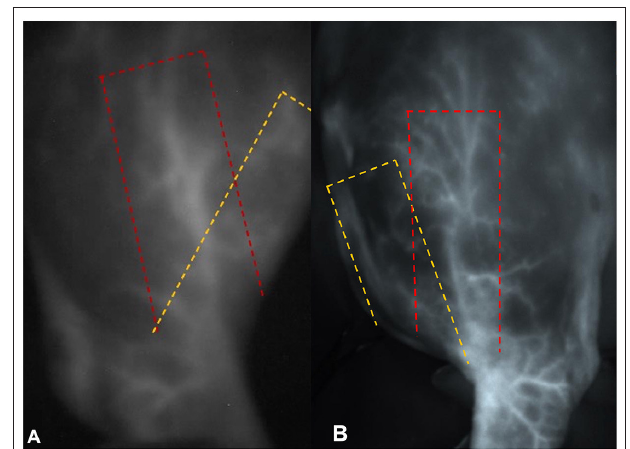
FIGURE 4 | Photographs of the near infrared signal of the superficial brachial artery in (A) dog 1 and (B) dog 2 (under ambient light). In both pictures the yellow dashed line shows the theoretical anatomical landmarks of the flap, while the red dashed line shows the individual course of the